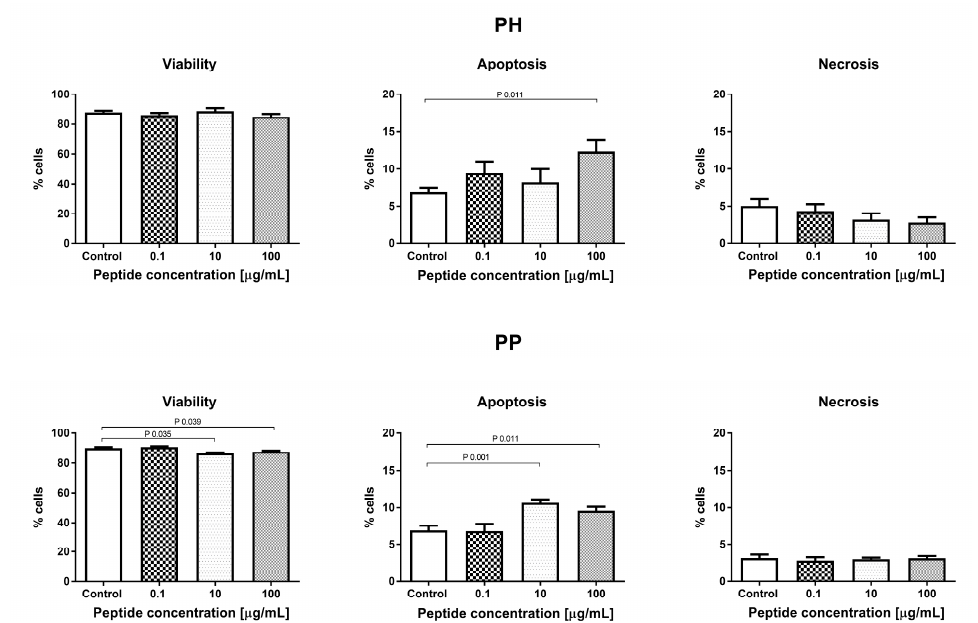
Figure 8. Evaluation of cell apoptosis, necrosis, and viability with PH and PP.